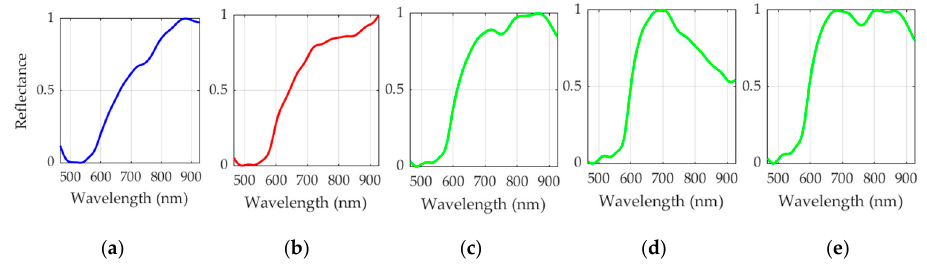
Figure 6. Reference spectral signatures included in the skin/PSL library. Benign ( a ) and malignant ( b ) PSL spectral signatures. ( c – e ) Three different normal skin spectral signatures of the training dataset.